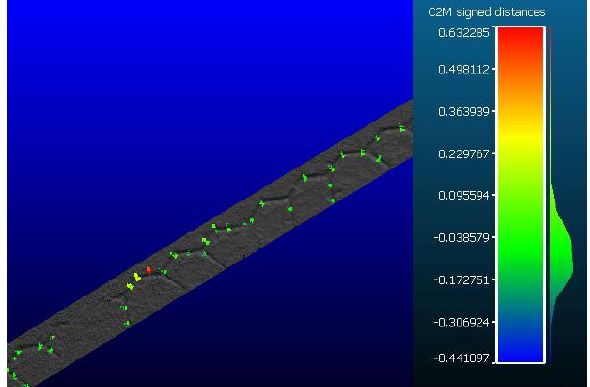
Figure 10. The value and the deviation of 3D differences between the GNSS points and the DTM generated from LiDAR